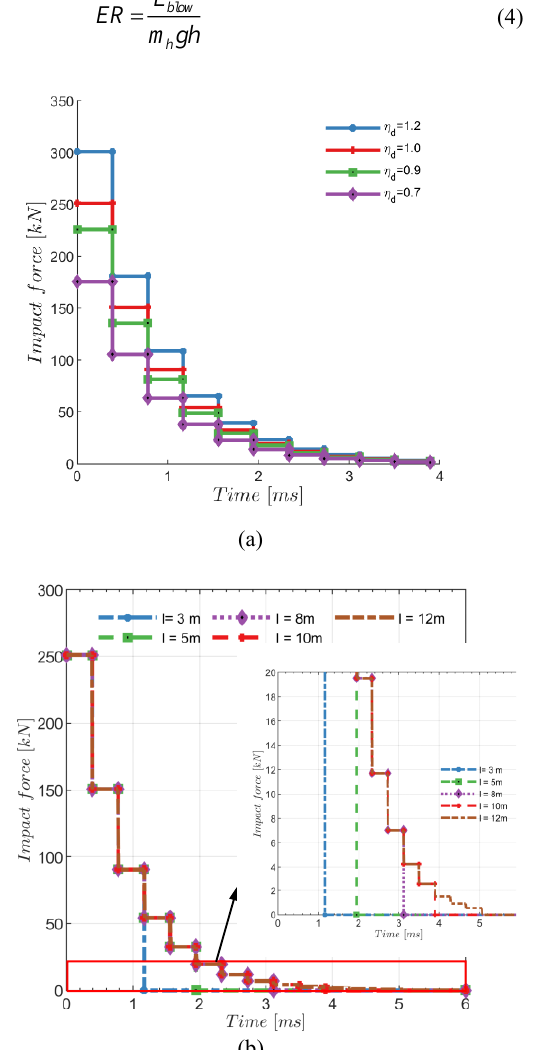
Fig. 2. Force-time configurations for (a) various dynamic efficiencies and (b) various rod lengths.